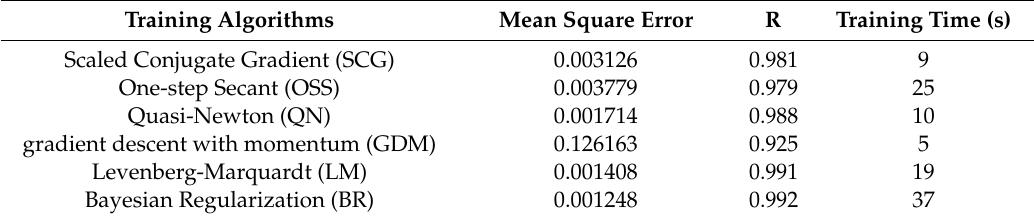
Table 3. Performance of brake intensity recognition using the close-loop NARX network with di ff erent training